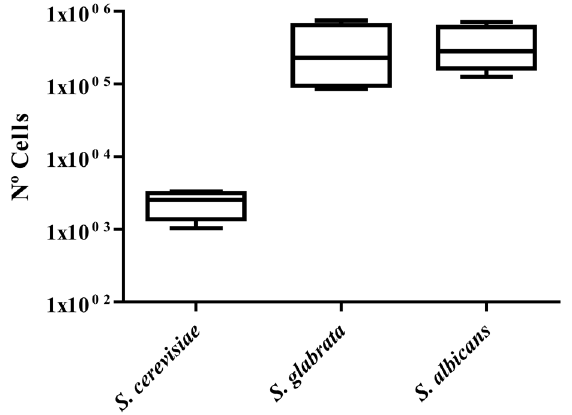
Figure 2. Box graph comparing the number of cells able to cross the endothelial barrier in the three yeast species.